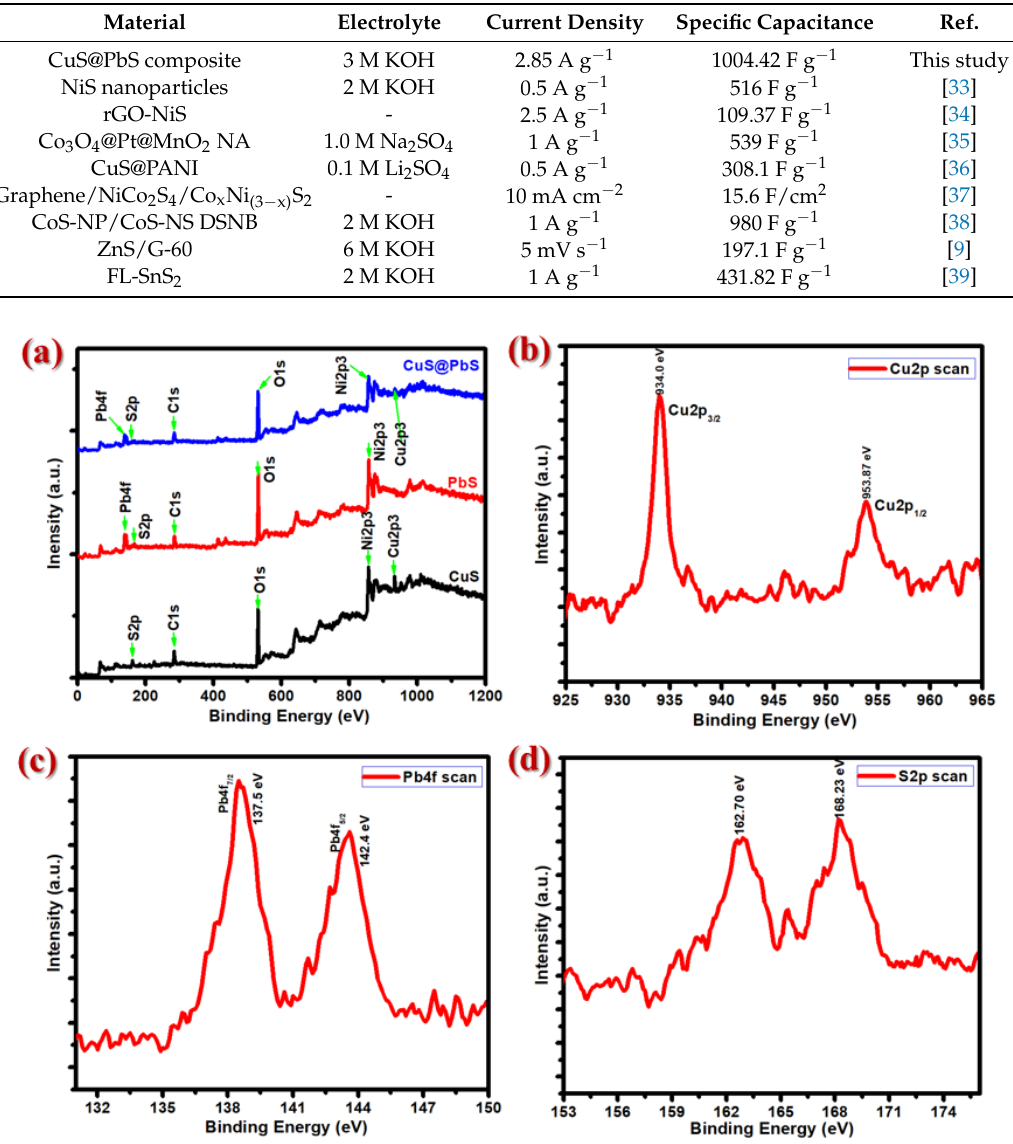
Figure 4. ( a ) XPS survey spectrum of CuS, PbS and CuS@PbS composite. ( b ) Cu2p scan, ( c ) Pb4f scan and ( d ) S2p core level spectra of CuS@PbS